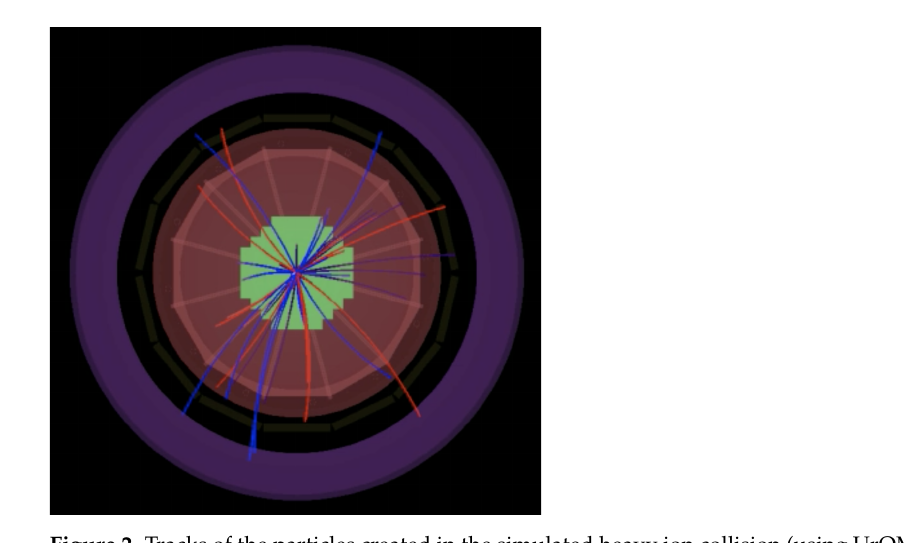
Figure 2. Tracks of the particles created in the simulated heavy ion collision (using UrQMD generator and MPD detector geometry), where negatively charged particles are marked in blue, and positive in red.